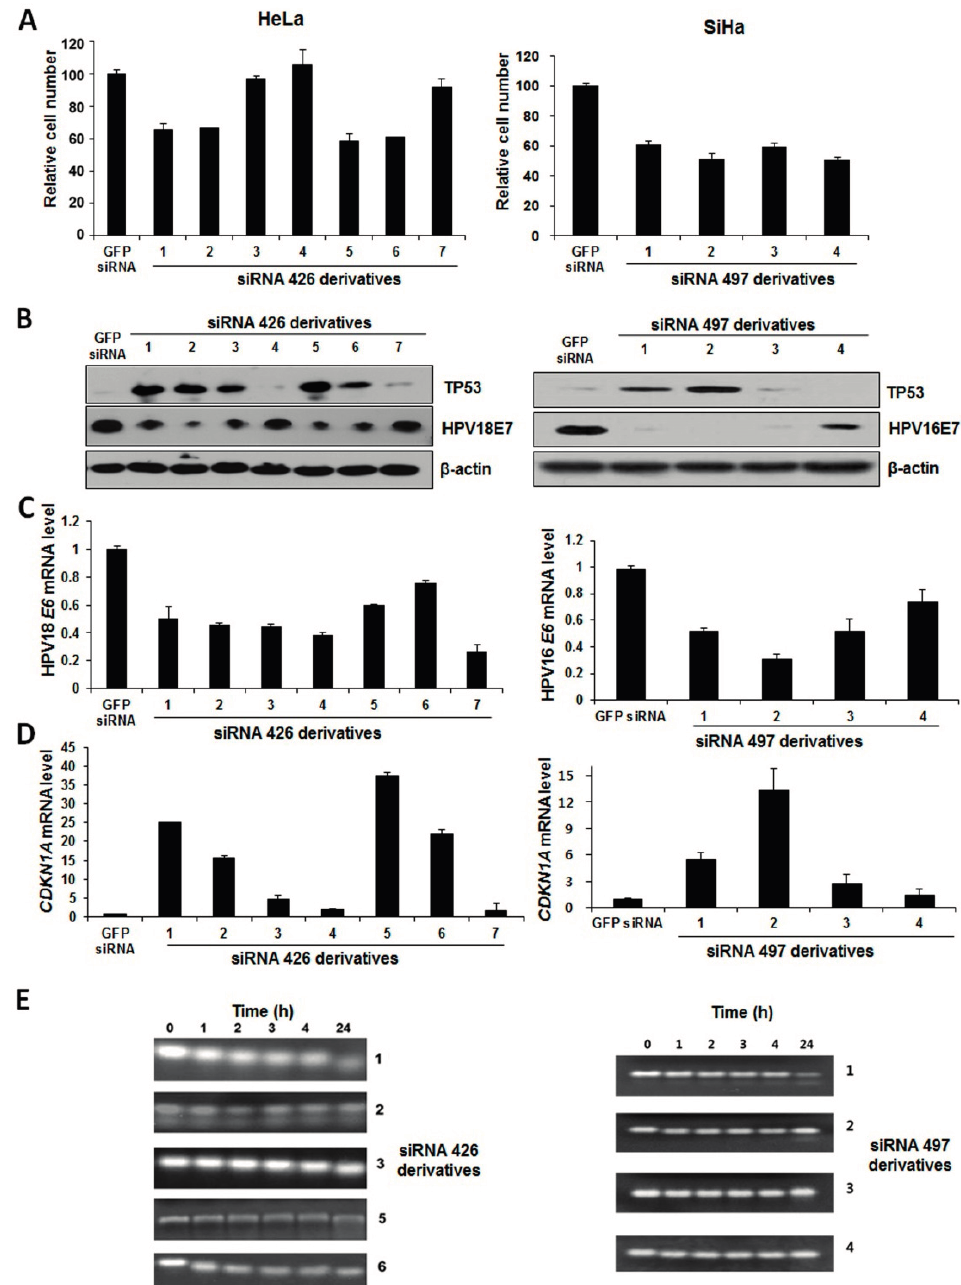
Figure 3. Determining the stability and silencing activities of chemically-modified derivatives of HPV16- and 18 E6/E7-specific lead siRNAs. ( A ) Trypan blue assay showing the number of viable HeLa cells transfected with 2 ʹ -OMe-modified derivatives of siRNA 426 and SiHa cells transfected with 2 ʹ -OMe modified derivatives of siRNA 497. GFP-specific siRNA (control siRNA) served as controls; ( B ) Silencing efficiency of 2 ʹ -OMe-modified siRNA derivatives on E7 expression and changes in TP53 expression were also analyzed by Western blotting. β -actin was used as a loading control; ( C ) E6 and ( D ) CDKN1A mRNA expression as determined by qRT-PCR; and ( E ) Gel electrophoresis analysis showing the serum stability of 2 ʹ -OMe-modified siRNA derivatives. Unmodified (Lane 0) and modified siRNA 426 or 497 derivatives were analyzed by electrophoresis on 15% native polyacrylamide